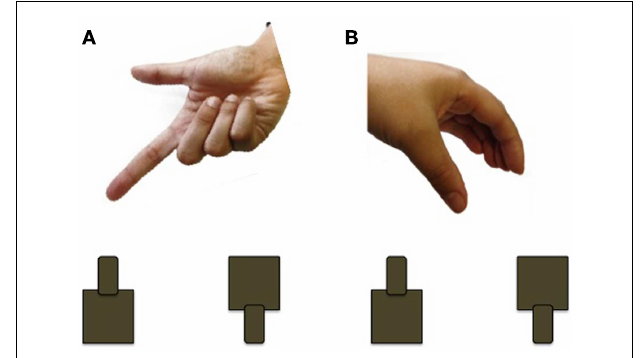
FIGURE 3 | Example of the cueing used by Stoit et al. ( 51). (A) Pointing cue to indicate cylinder to be grasped (left or right); (B) hand shape cue to indicate cylinder to be grasped (precision or